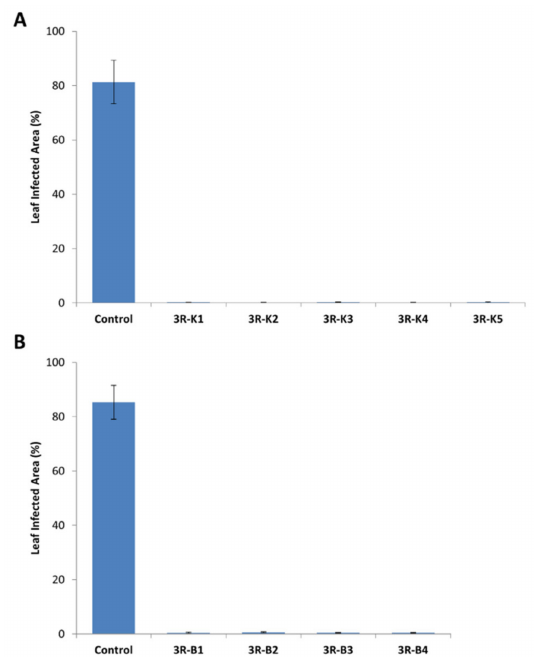
Figure6. EvaluationoftransgenicKingEdwardandB101linestransformedwiththetripleresistance(3R: RB, Rpi-blb2, and Rpi-vnt1.1) gene stack against P. infestans in detached-leaf assays. ( A )